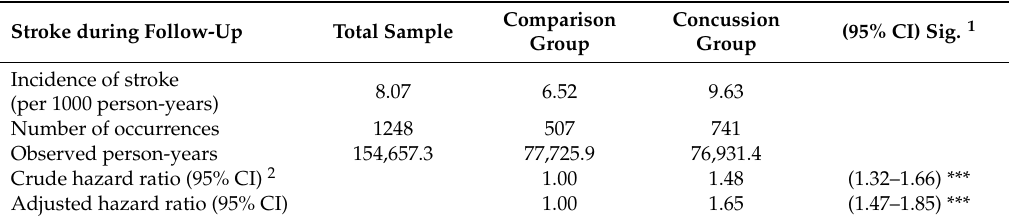
Table 2. Incidence rates, crude hazard ratio, adjusted hazard ratio of stroke in the comparison group and concussion group ( n = 27,304, 1998–2005).